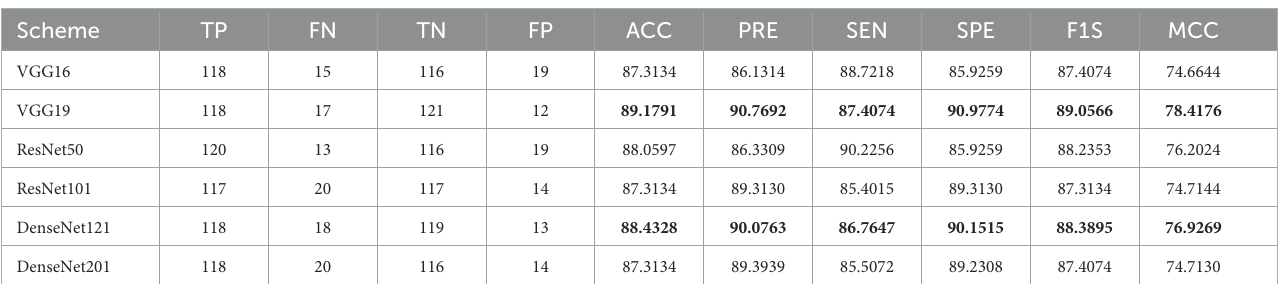
TABLE 3 Classification results achieved for raw renal CT slice with a SoftMax classifier.